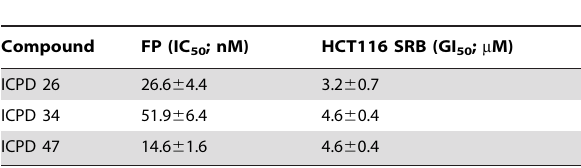
Table 2. Hsp90 binding and inhibitory